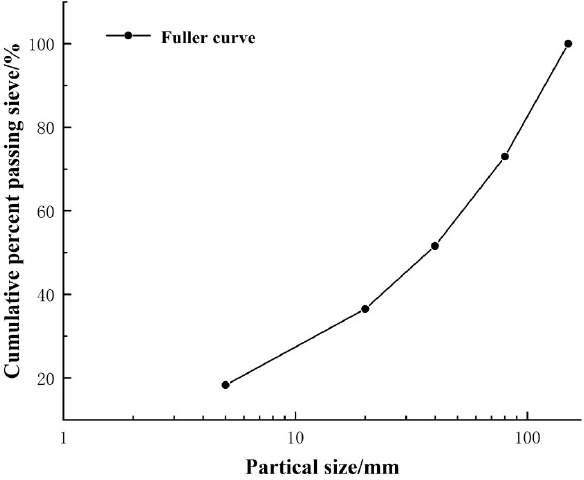
Figure 1: Fuller curves of